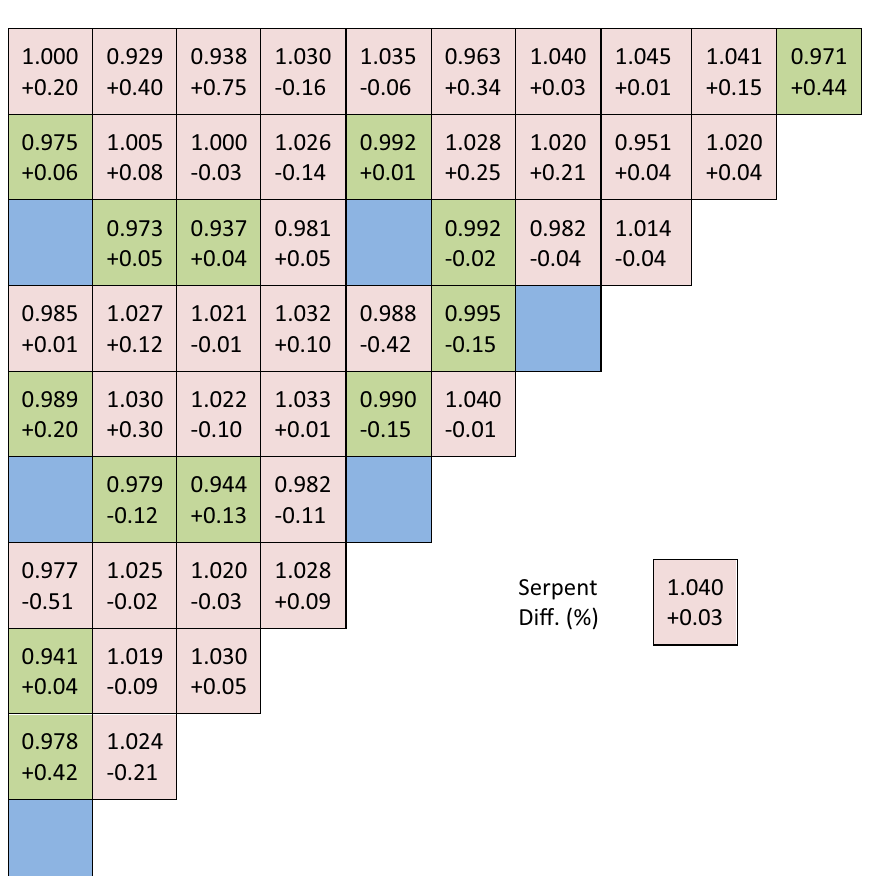
Fig. 7. Top right octant assembly (4.45 w / o and 156 IFBA rods) radial power distribution (WIMS vs. Serpent) at zero burnup; IFBA rods are indicated in